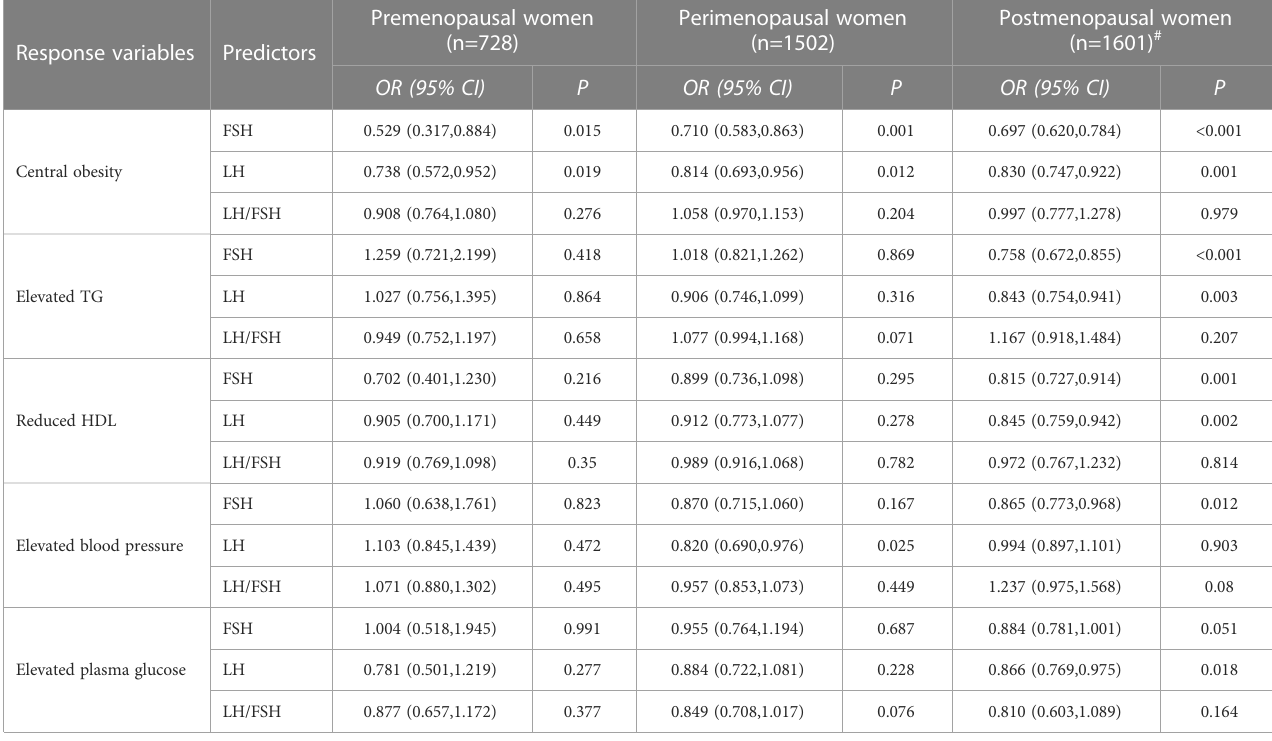
TABLE 2 The associations of FSH, LH, and LH/FSH with components of metabolic syndrome ※